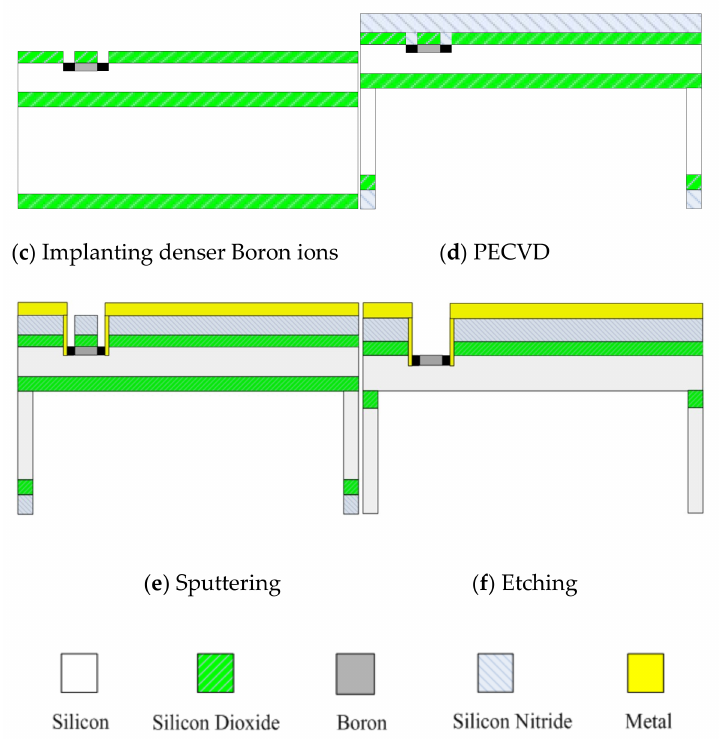
Figure 8. The processing technology of the four-beam microstructure.